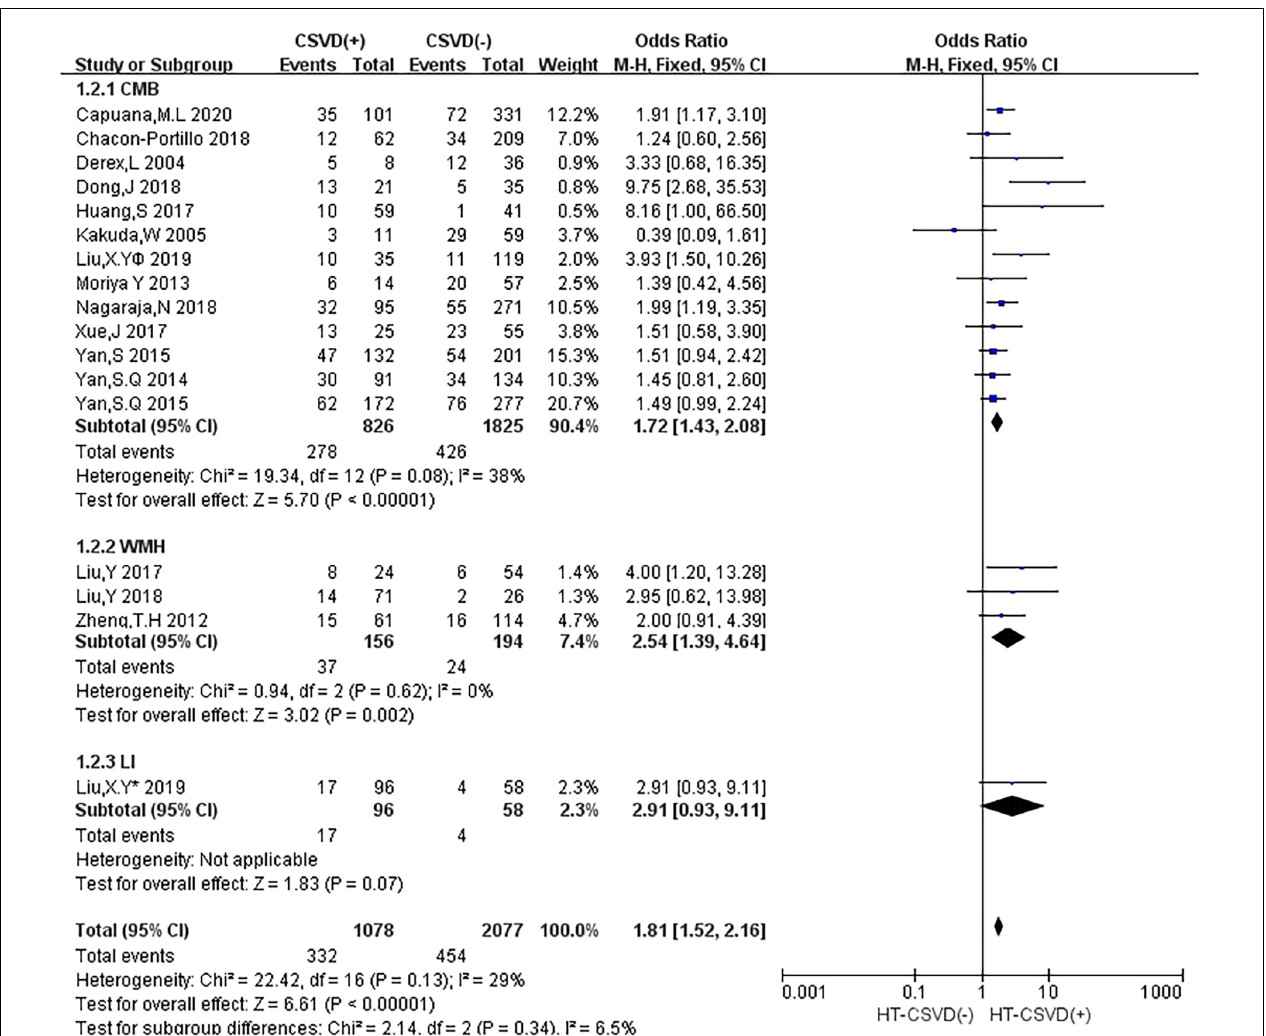
FIGURE 3 | Forest plot of subgroup analysis showing the impact of subtypes of CSVD on HT.